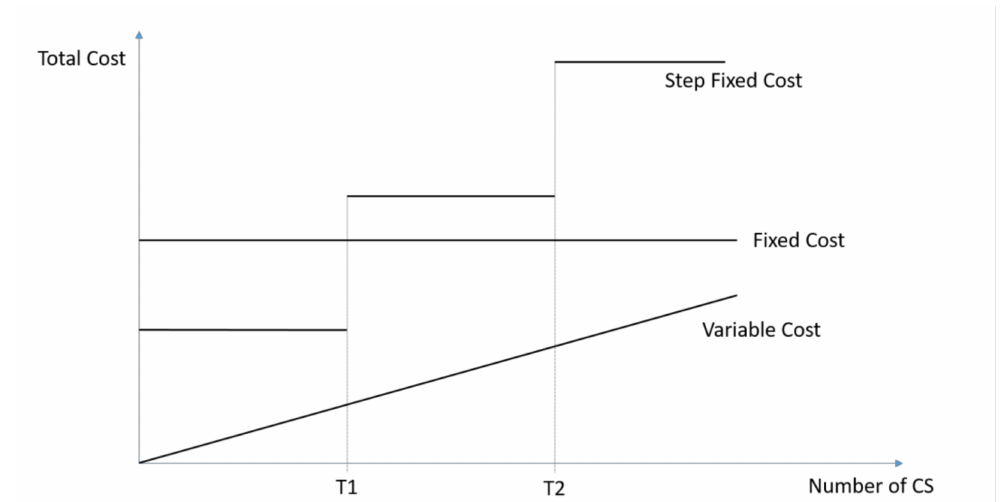
Figure 1. Variable, Fixed, and Step Fixed